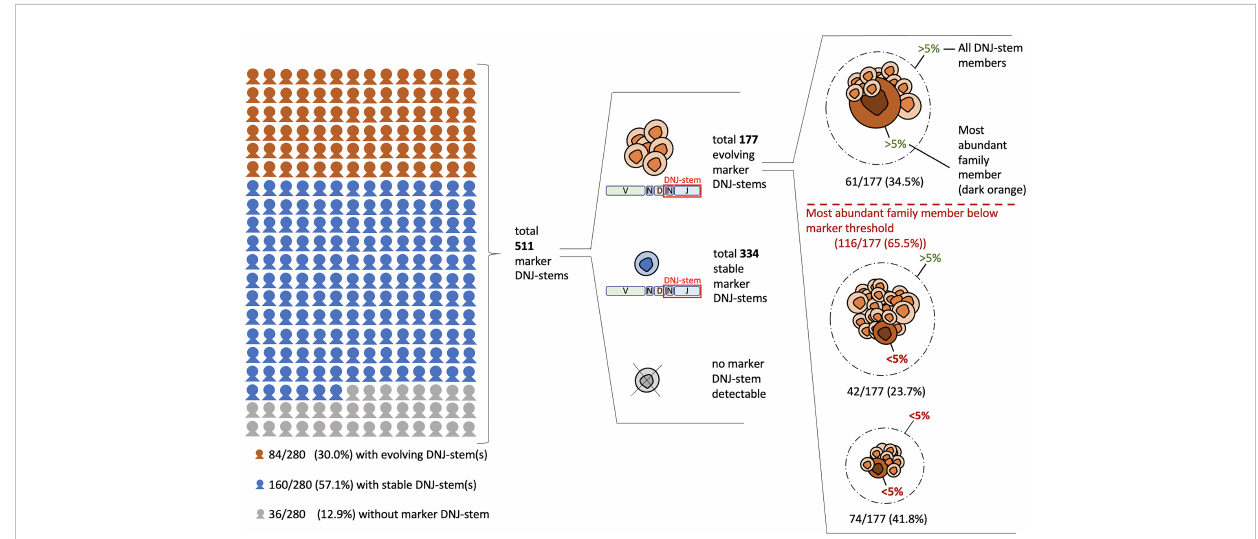
FIGURE 2 Clonal evolution and clonotypic abundances in diagnostic BCP-ALL samples (cohort #1). The fi gure is displaying the prevalence of clonal evolution in reference to all 280 patients and in reference to the total of 511 detected marker DNJ-stems. Additionally, the evolving DNJ-stems are itemized by their most abundant family member abundance and total DNJ-stem abundance relating to the 5% marker